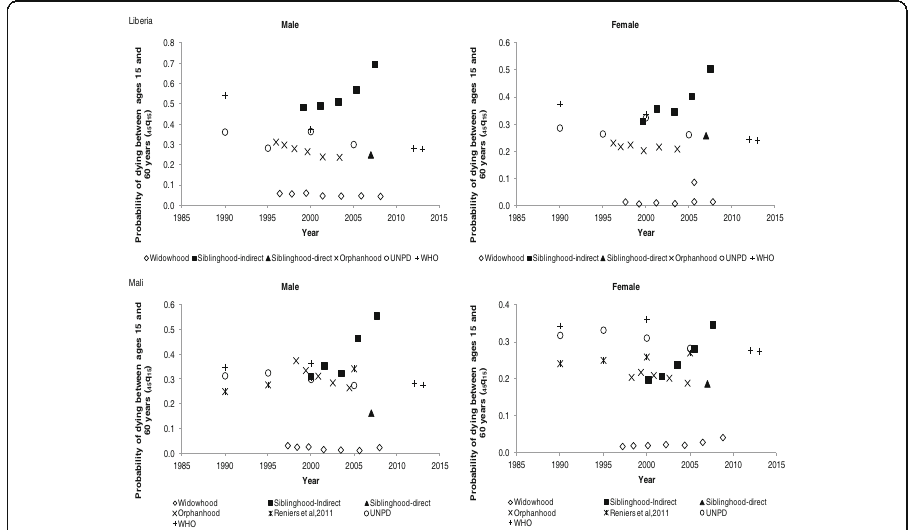
Fig. 6 Probability of dying between ages 15 and 60 years ( 45 q 15 ) by sex in Liberia and